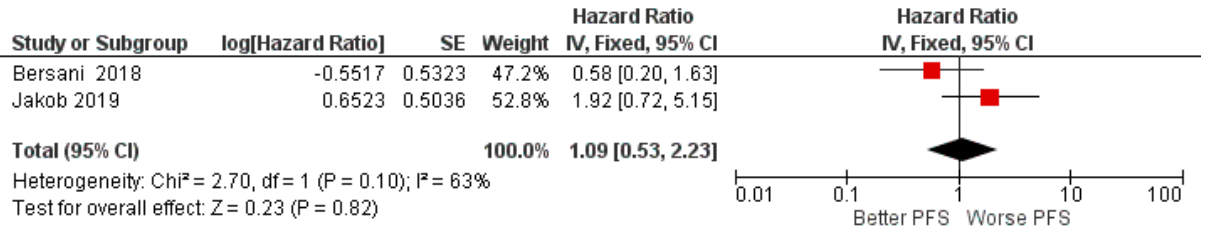
Figure 4. Forest plot of the fixed effects model of the meta-analysis; DFS, HR = 1.09, 95% CI: [0.53 5.15].